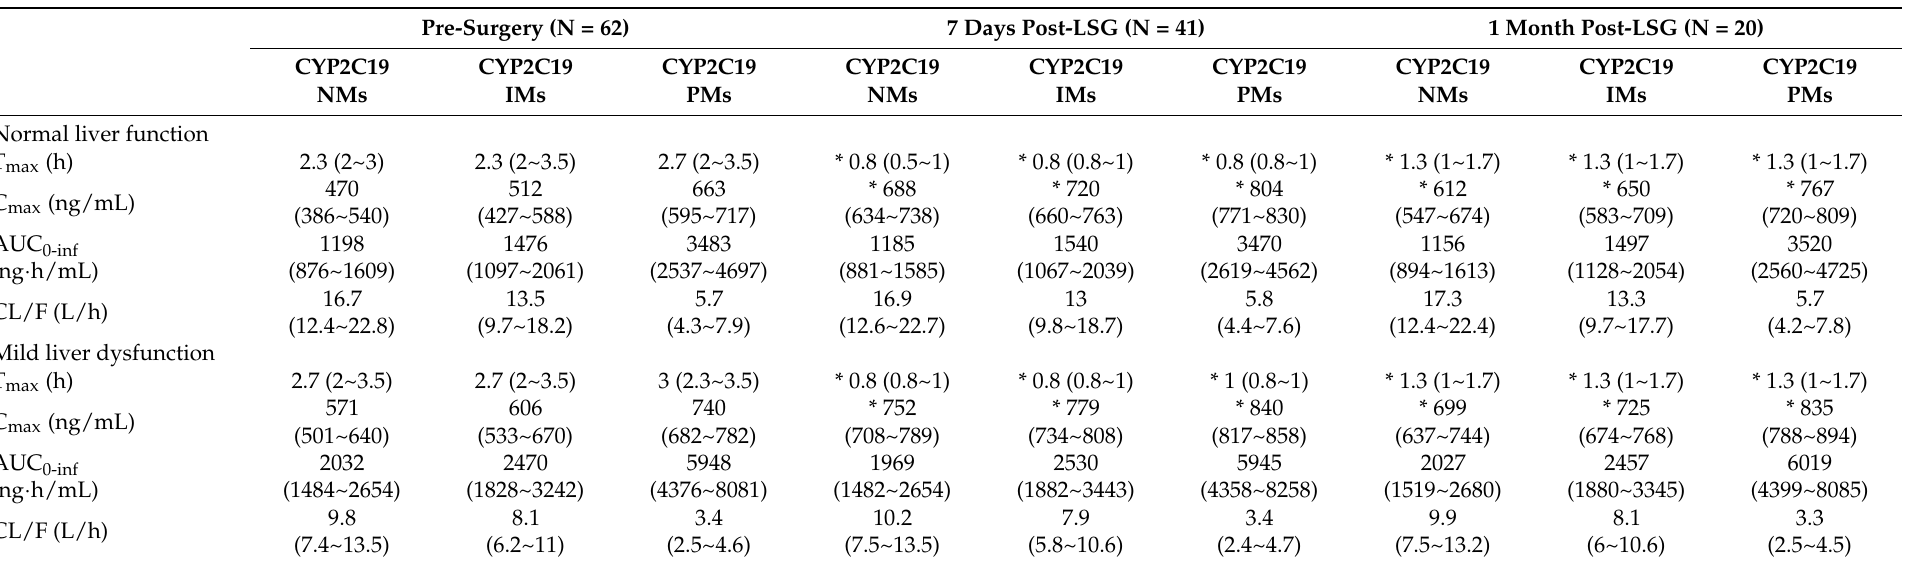
Table 3. Pharmacokinetic parameters for 20 mg omeprazole before and after LSG based on 1000